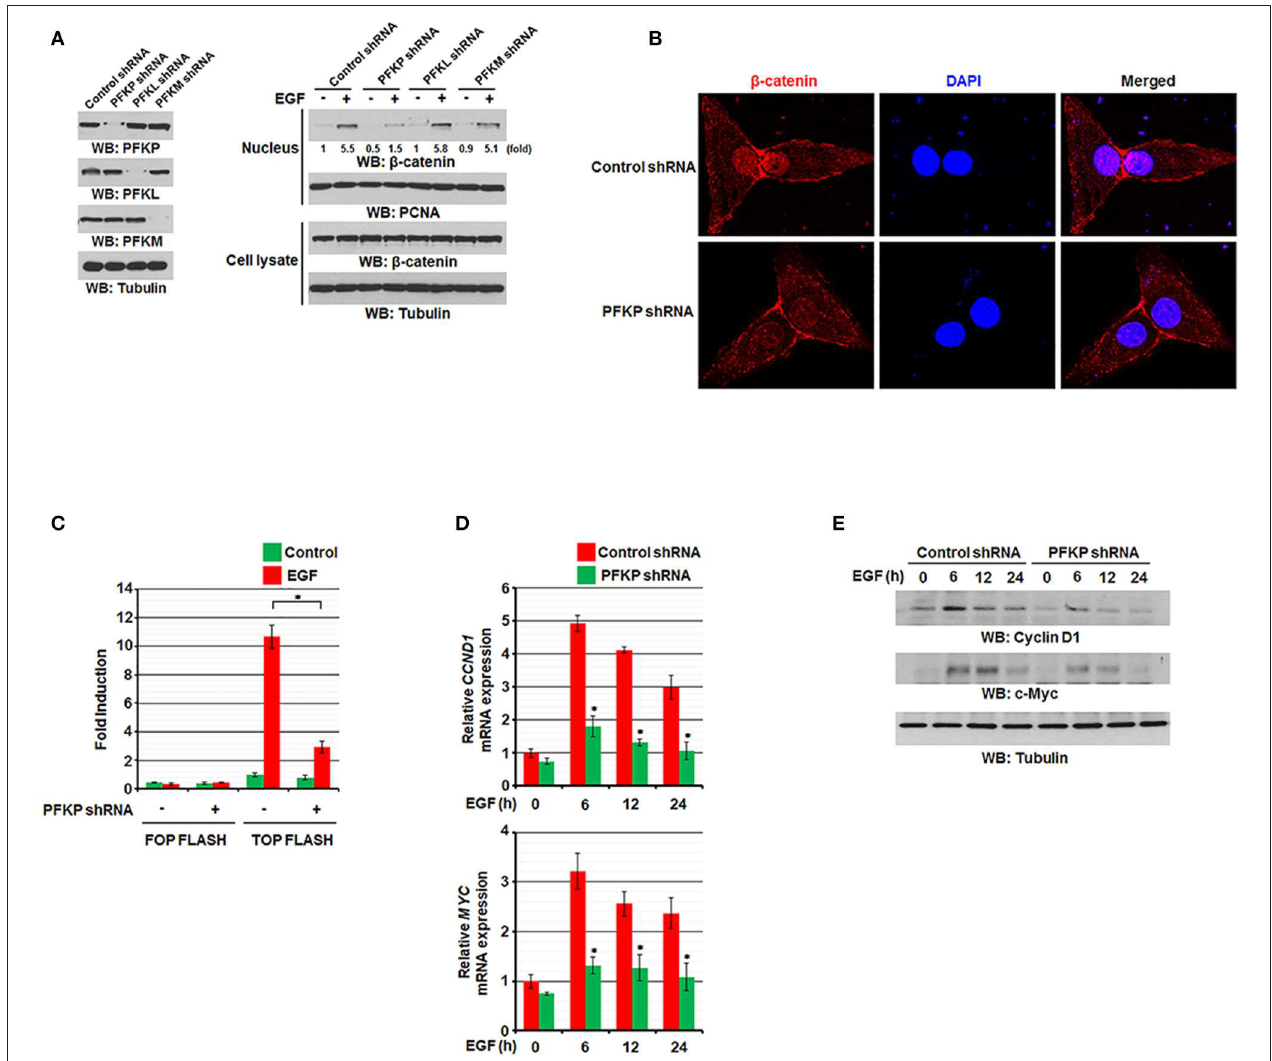
FIGURE 1 | PFKP expression is required for EGFR activation-induced nuclear translocation and transactivation of β -catenin. (A) Serum-starved U87/EGFR cells with the indicated shRNAs (left panel) were treated with or without EGF (100ng/ml) for 9h. The cells were harvested for the isolation of nuclear fractions (right panel). Immunoblotting analyses were performed with the indicated antibodies. (B) U87/EGFRvIII cells were stably expressed with control shRNA or PFKP shRNA. Immunofluorescent staining was performed with an anti- β -catenin antibody. (C) U87/EGFR cells with or without PFKP depletion were transfected with TOP-FLASH or FOP-FLASH, which was followed by EGF treatment for 6h. Luciferase activity was measured. The relative levels of luciferase activity were normalized to the levels of untreated cells and to the levels of luciferase activity in the Renilla control plasmid. Data represent the means ± SD of three independent experiments. * P < 0.001, based on the Student’s t -test. (D,E) Serum-starved U87/EGFR cells with or without depleted PFKP were treated with or without EGF for the indicated periods of time. The mRNA expression levels (D) and the protein expression levels (E) of CCND1 and MYC in U87/EGFR cells were determined by real-time PCR and immunoblotting analyses with the indicated primers and antibodies, respectively. Data represent the means ± SD of three independent experiments. * P < 0.001, based on the Student’s t -test.